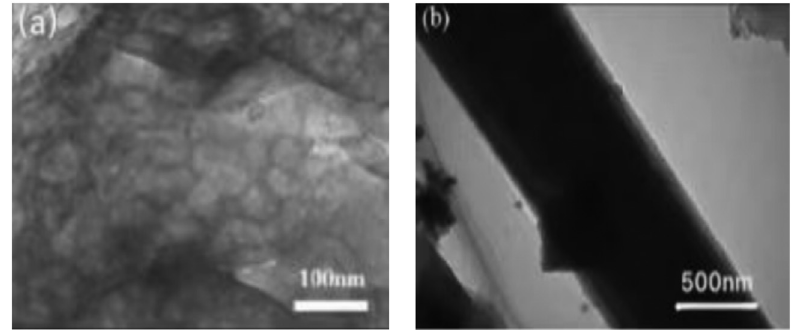
Figure 9: TEM characterization of GCB, GCC, and GCBC composite samples. ( a ) TEM diagram of GCBC and ( b ) GCBC at di ff erent resolutions.